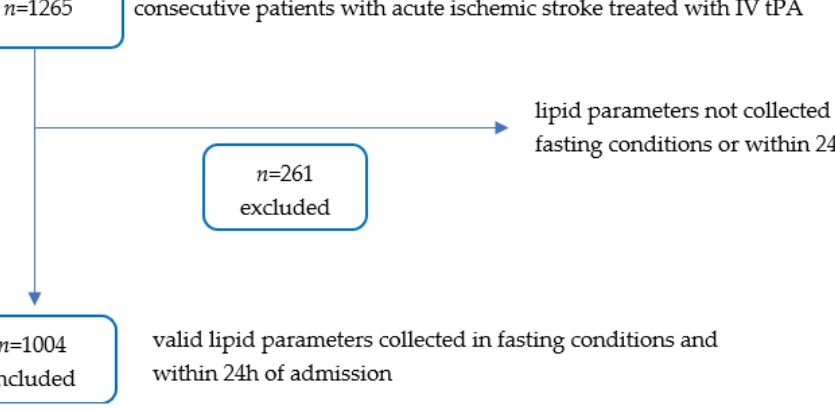
Figure 1. Flow Diagram Illustrating Only Patients with Valid Lipid Parameters were